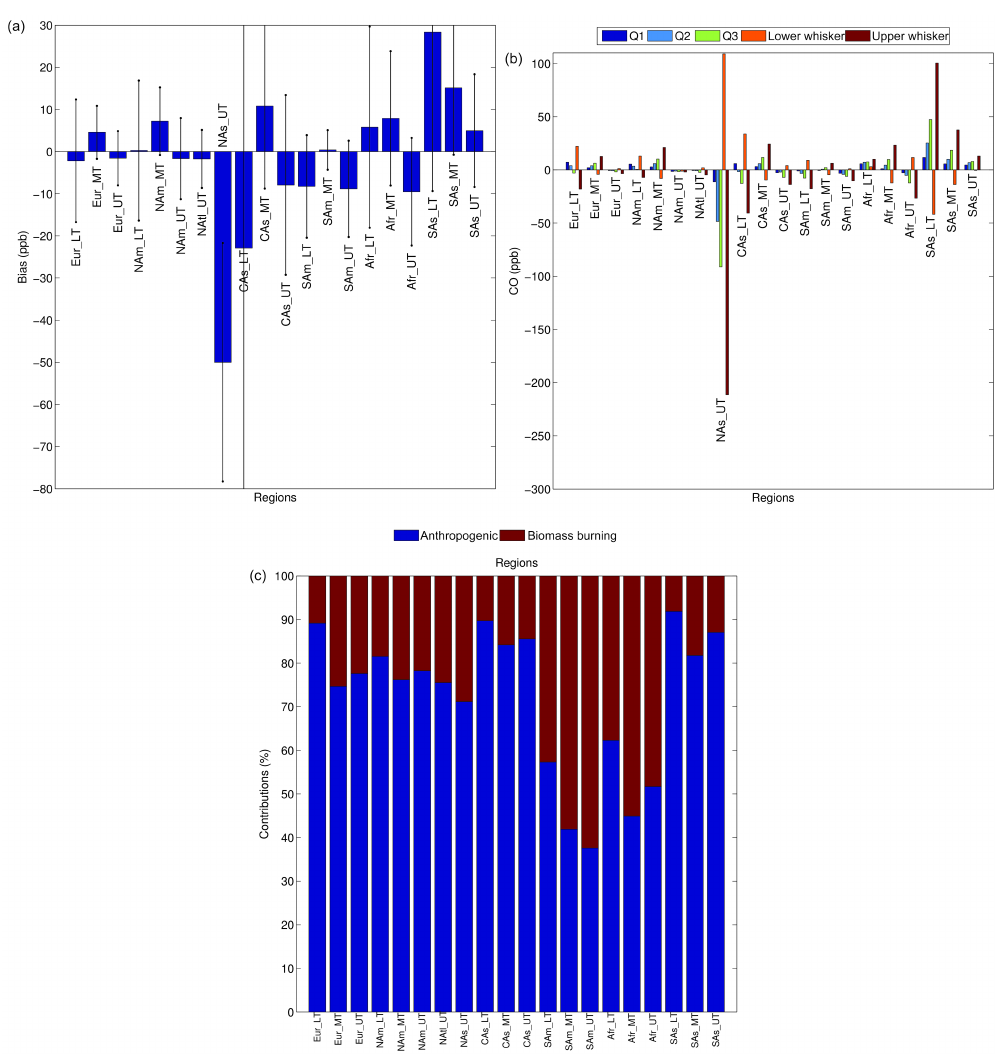
Figure 10. (a) Mean bias (blue) and mean standard deviation bias (black) between the modeled and observed CO anomalies. (b) Percentiles of the modeled CO anomalies bias with respect to observations. (c) Relative contribution from anthropogenic and biomass burning sources to the modeled CO. The three graphs are for the main sampled regions (Europe, North America, North Atlantic, northern Asia, central Asia, South America, Africa, southern Asia) and in three layers (LT, MT, UT), using MACCity and GFAS v1.2 for the 2003–2013 period. Biomass burning vertical injection uses APT